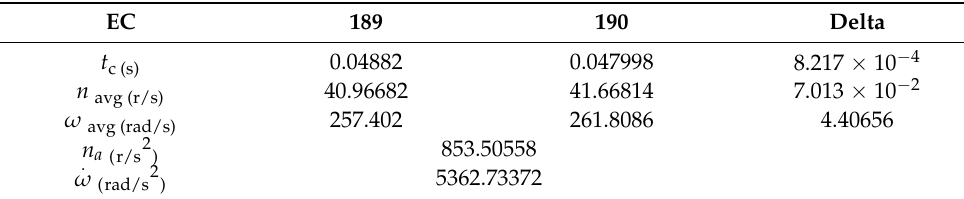
Table 3. Acceleration calculation for ECs 189 and 190.